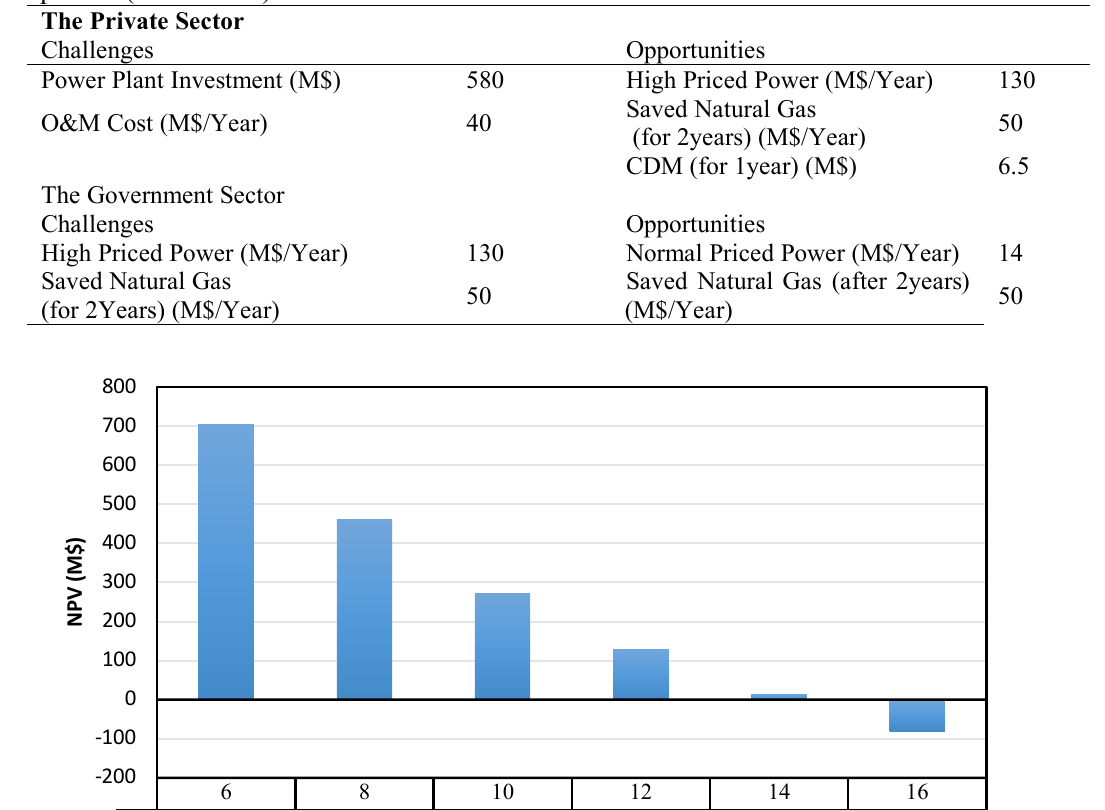
Table 16 . Economic opportunities and challenges of the private sector as power plant investor and operator (1 st Scenario)